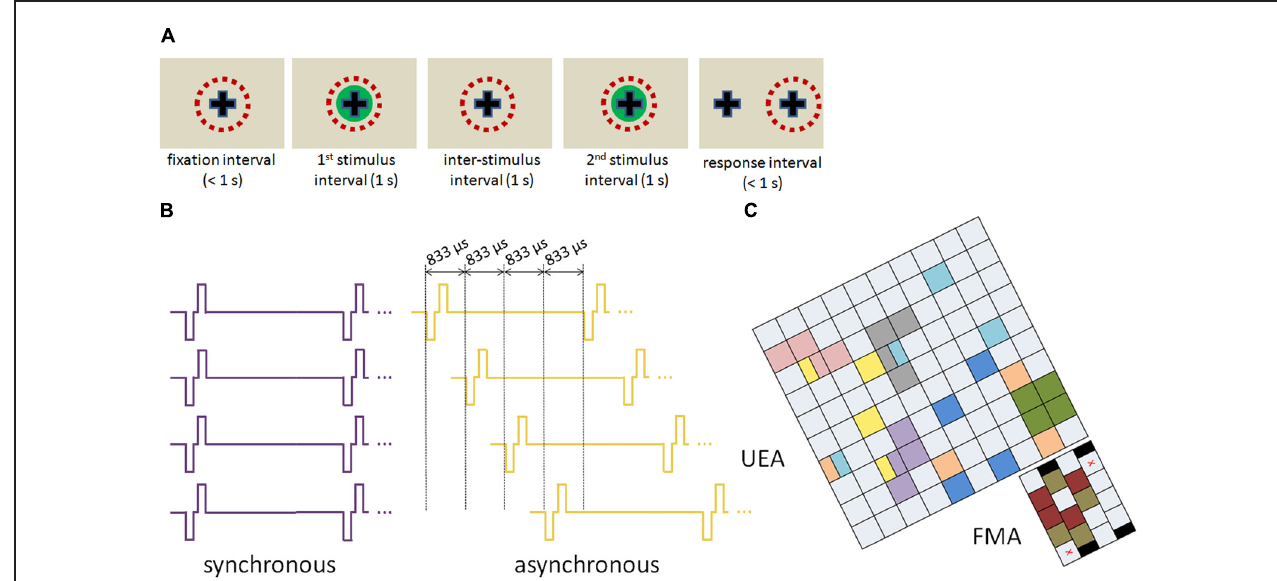
FIGURE 1 | Experimental design. (A) Structure of a trial. The red dashed circle denotes the animal’s direction of gaze; on this example trial, the animal responded right. (B) Timing of synchronous and asynchronous ICMS for a quad